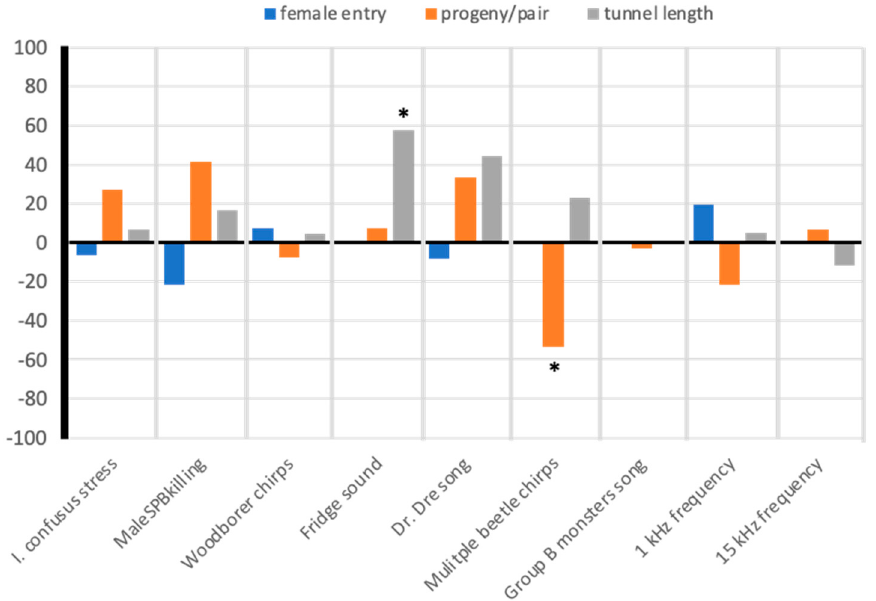
Figure 8. Relative effect (%) of acoustic treatments compared to controls (no vibroacoustic input) on female Ips confusus entry into male gallery hole (blue bars), progeny per beetle pair (orange bars) and tunnel length (created by female beetle; grey bars). A positive value means that beetles performed better in the acoustic treatment log than the control log, and a negative value mean that beetles performed poorer in the acoustic treatment log than in the controls log. * indicates a slight significant ( p < 0.10) difference from the control.